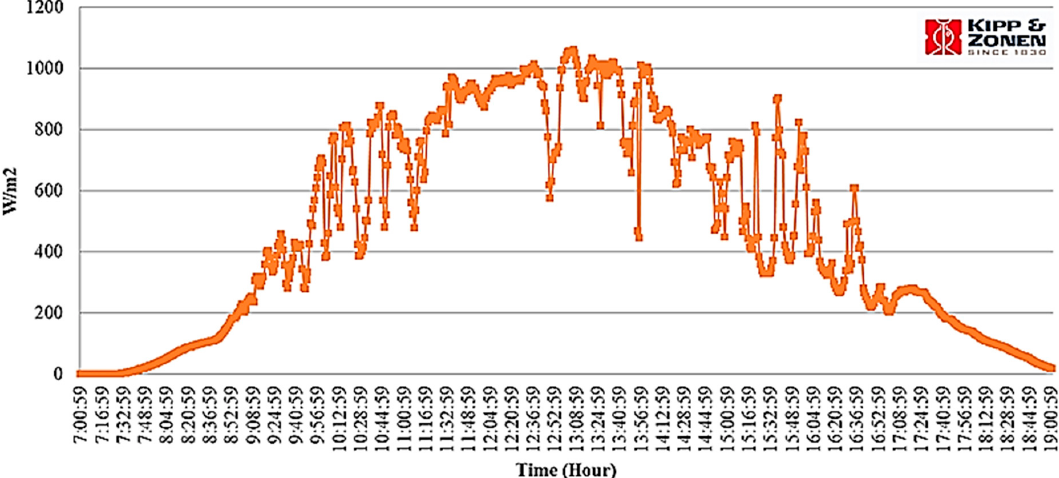
Figure 4. Actual solar irradiance measurement data at Nilai, Negeri Sembilan, Malaysia. Table 4. Maximum demand captured during peak hours.